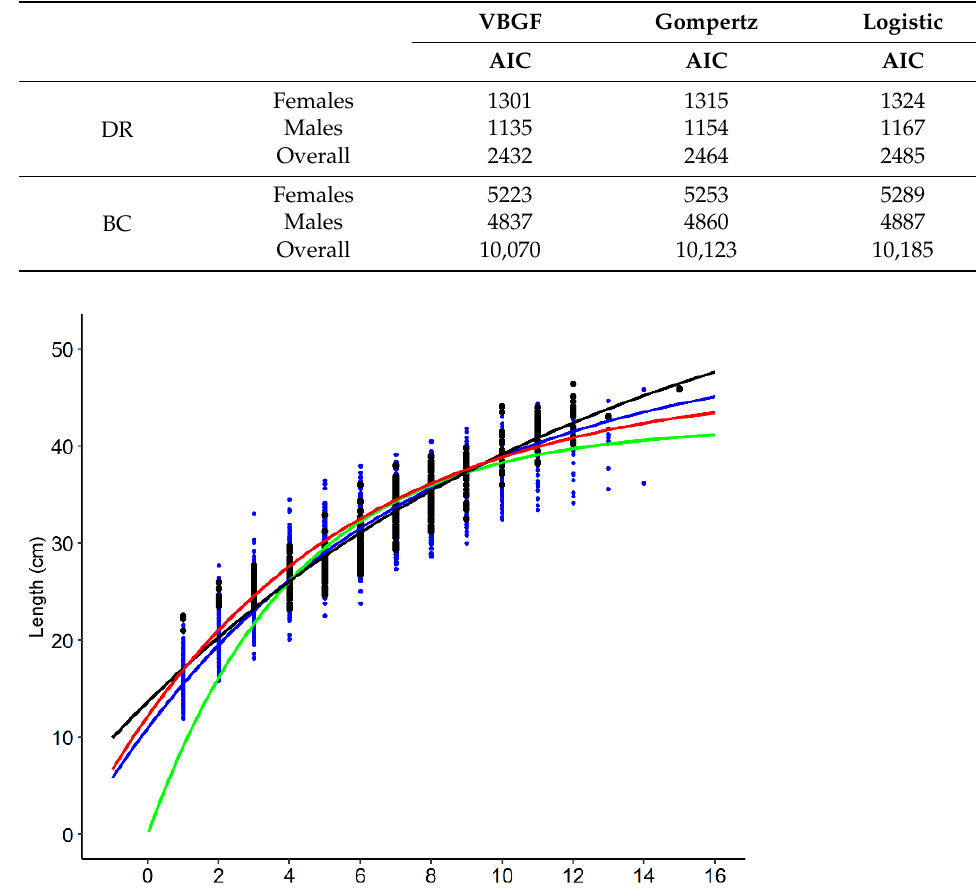
Table 3. Summary results of growth model selection applied to each data set of length-at-age of Trachurus picturatus from Portuguese continental coast. For each model is indicated the Akaike Information Criterion (AIC) with the best value for each data set in bold. VBGF—von Bertalanffy growth function; Gompertz—Gompertz function; Logistic—logistic function; DR—direct readings; BC—back-calculation.